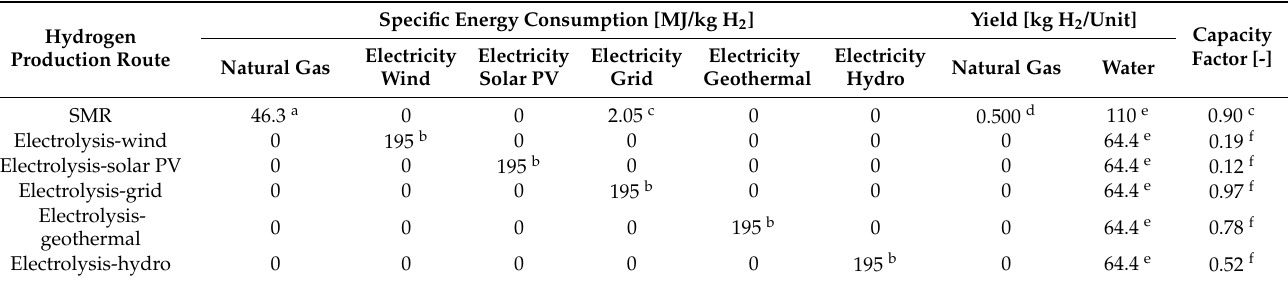
Table 5. Hydrogen production routes